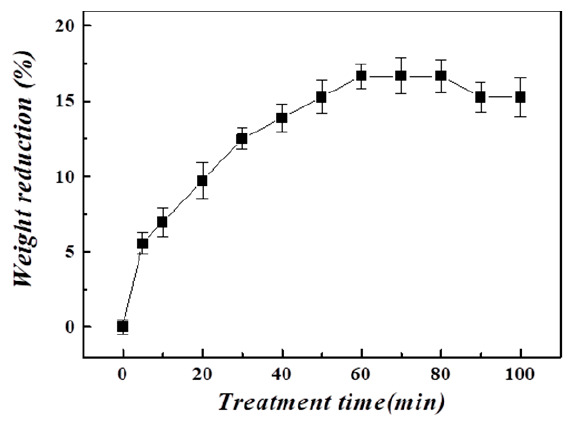
Figure 7. E ff ect of the acid-treatment time on the rate of weight loss of the stainless-steel fiber .